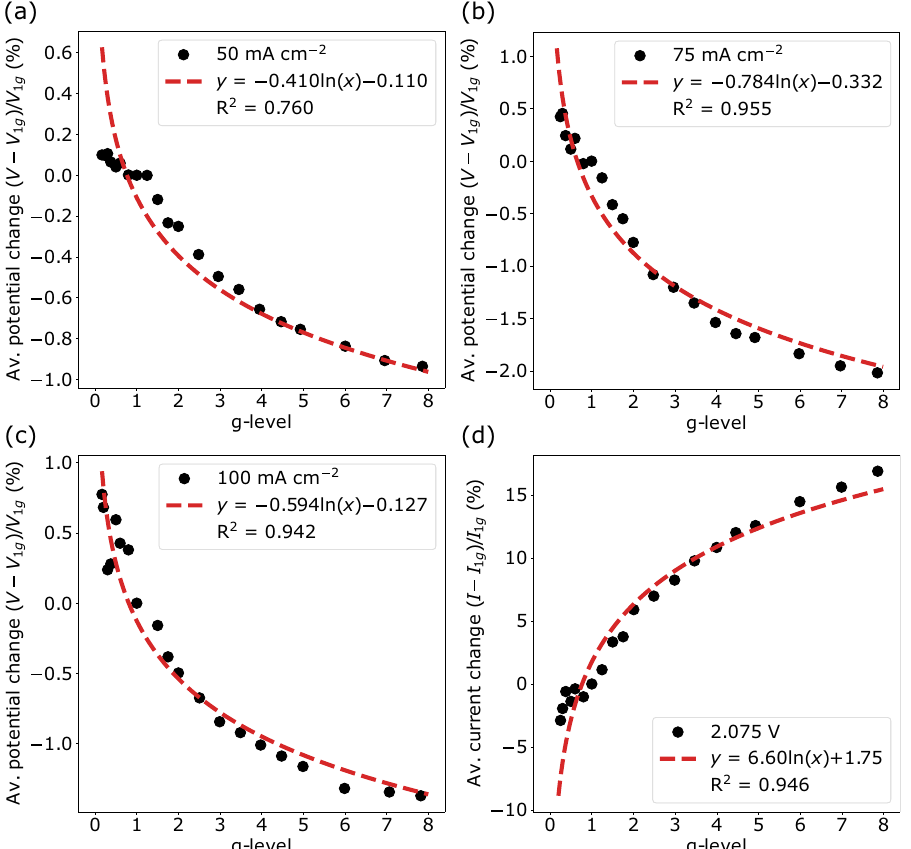
Fig. 7 Gravity dependent electrolysis ef fi ciency. The in fl uence of gravity (0.166 – 8 g) on electrolysis ef fi ciency represented as % change relative to 1 g